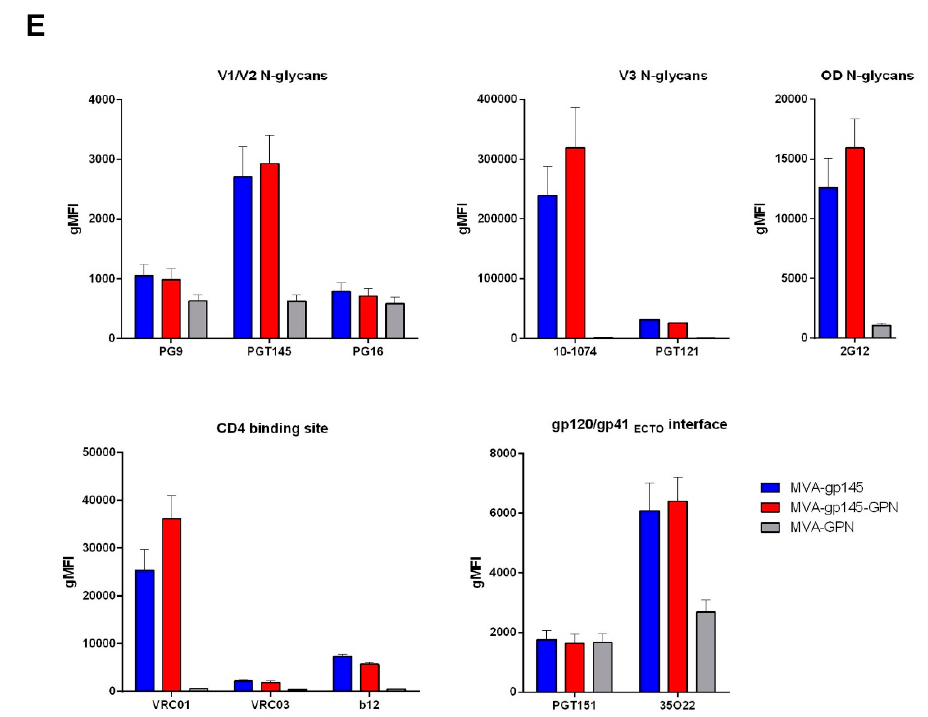
Figure 2. ( A – D ) Detection of Gag-induced virus-like particles (VLPs) by electron microscopy. HeLa cells were infected with MVA-GPN ( A , C ) or MVA-gp145-GPN ( B , D ) recombinant viruses at 5 pfu/cell and at 24 h.p.i. the supernatants were harvested, clarified, purified by ultracentrifugation through a 20% sucrose cushion, followed by a 20%–60% sucrose gradient, and then processed for negative staining ( A , B ) or immnogold labelling using anti-gp120 antibody ( C , D ), as described in Materials and Methods. Bar: 100 nm. ( E ) bNAbs binding profile to membrane-bound gp145 trimeric protein by flow cytometry. HeLa cells infected with MVA-gp145, MVA-gp145-GPN or MVA-GPN viruses were